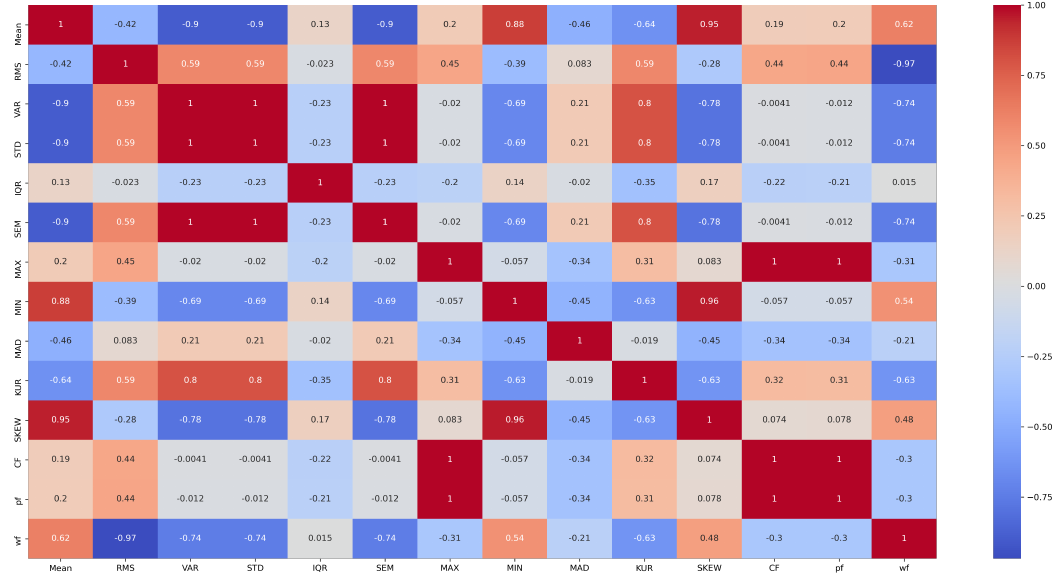
Figure 10. Feature extraction plot for the ESR